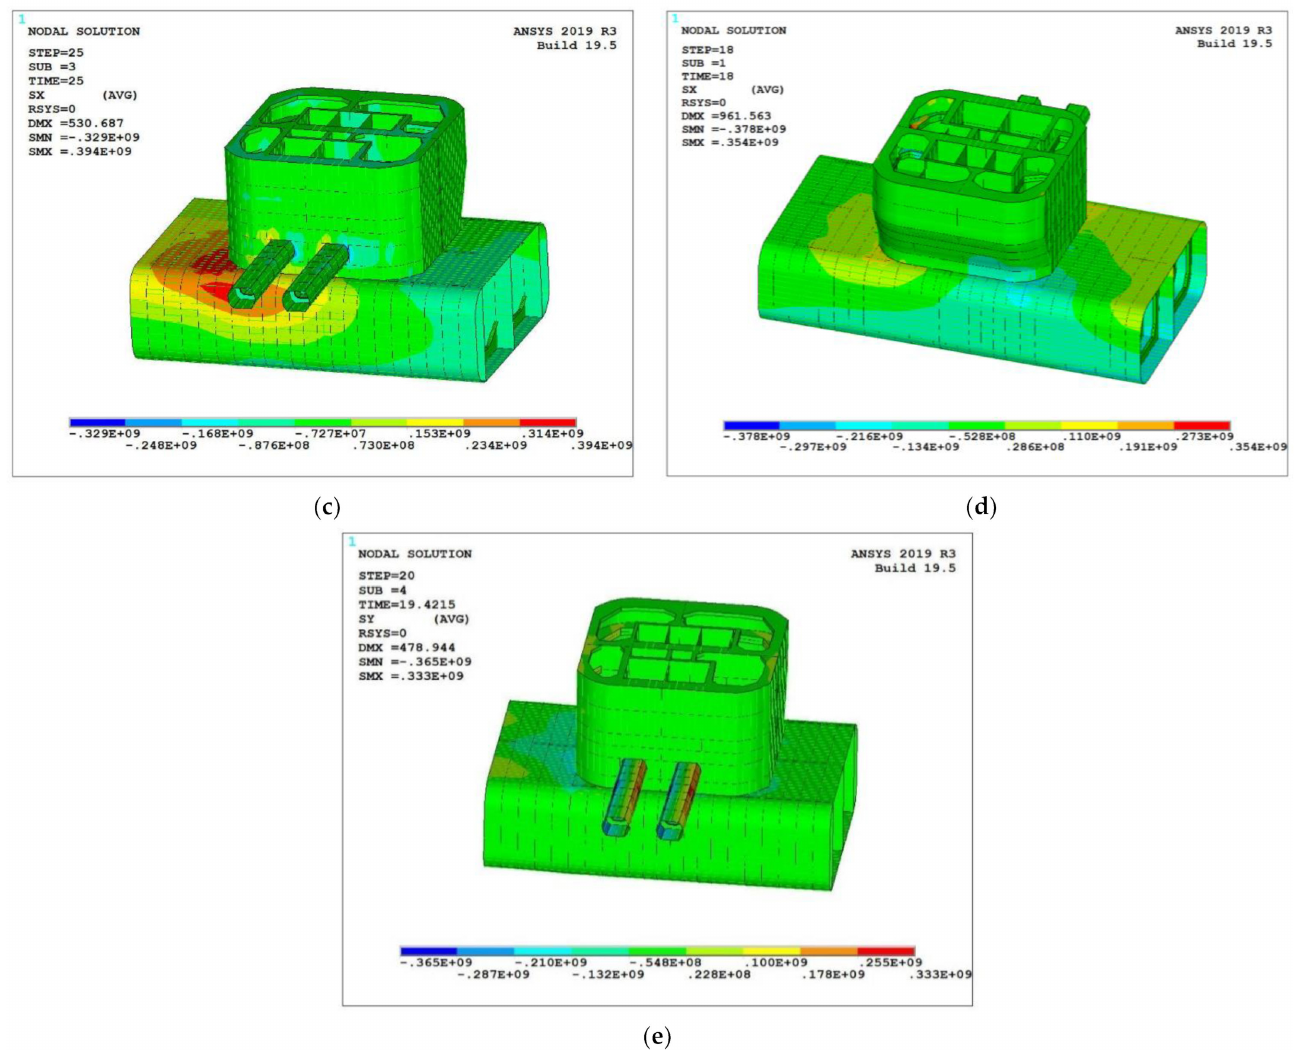
Figure 12. The main node deformation of the selected platform. ( a ) Shear between column and deck; ( b ) Column bending (vertical); ( c ) Pontoon shear (vertical); ( d ) Bending failure at the lower end of a column; ( e ) Bending failure at the end of transverse